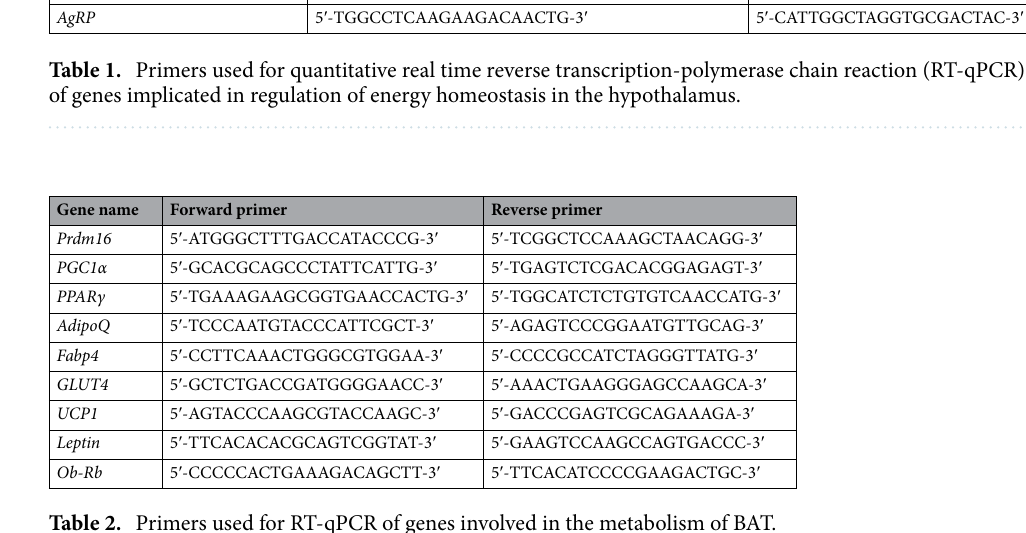
Table 2. Primers used for RT-qPCR of genes involved in the metabolism of